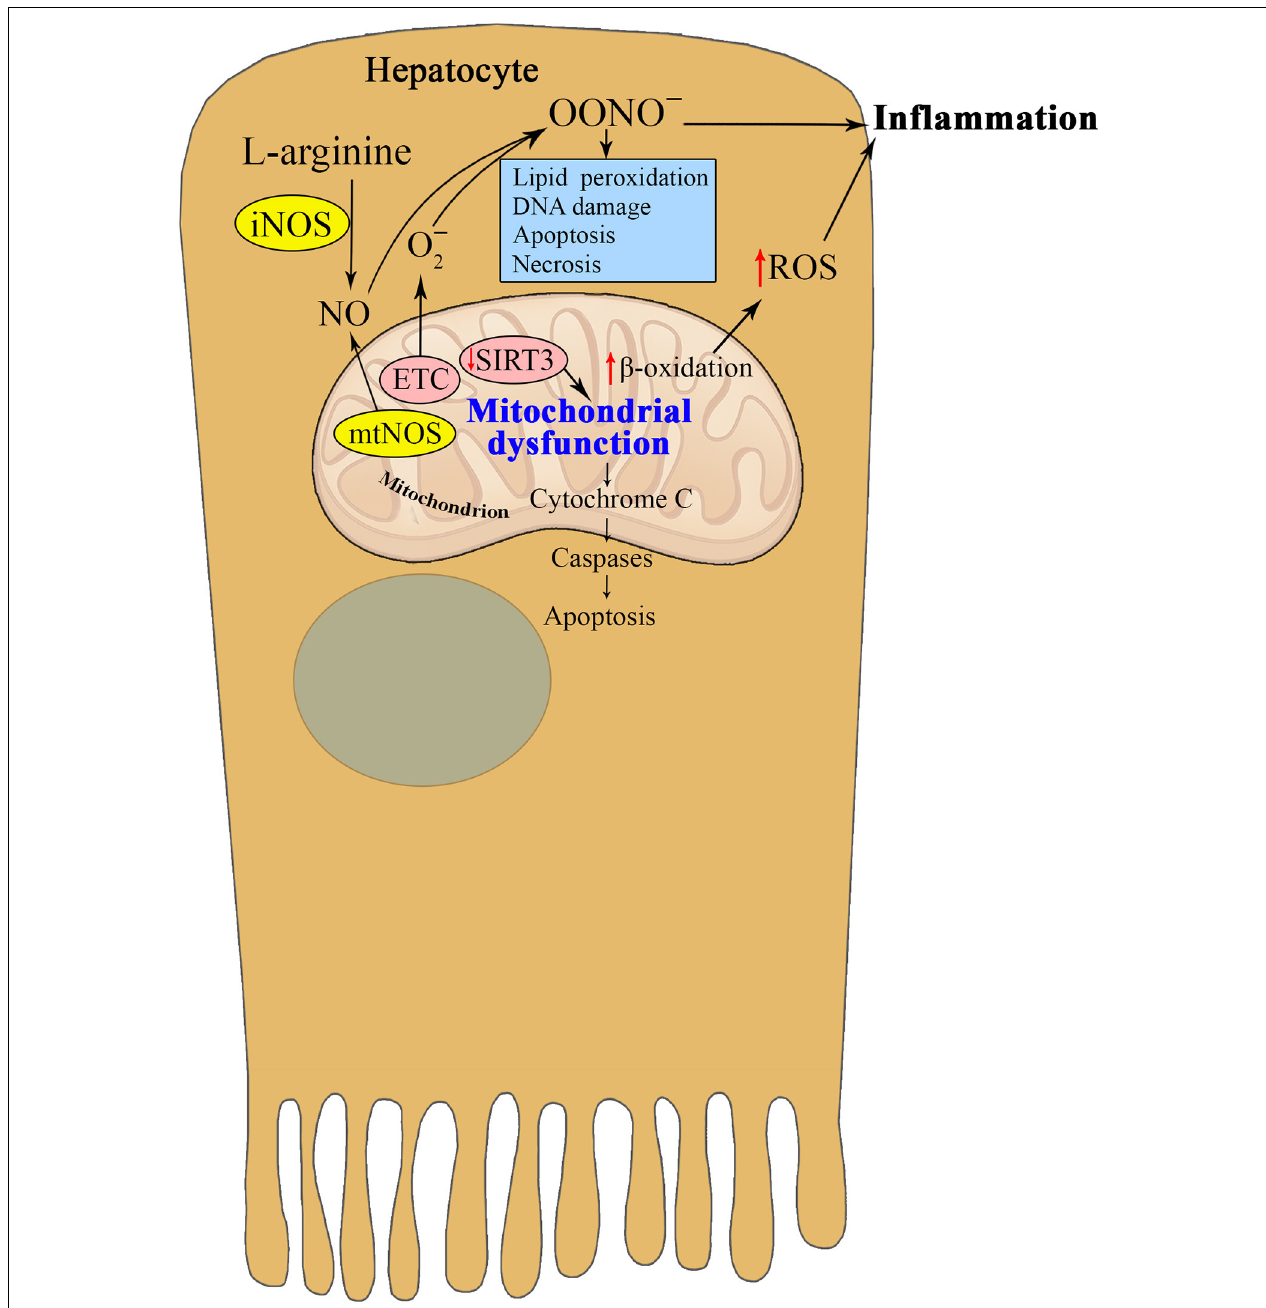
FIGURE 3 | Interrelation between nitric oxide and mitochondria in hepatocytes in metabolic syndrome. The enhanced activities of mtNOS and iNOS in hepatocytes during insulin resistance promote peroxynitrite production and cytochrome c release, which are associated with the peroxidation of mitochondrial lipids and apoptosis. Reduced SIRT3 activity